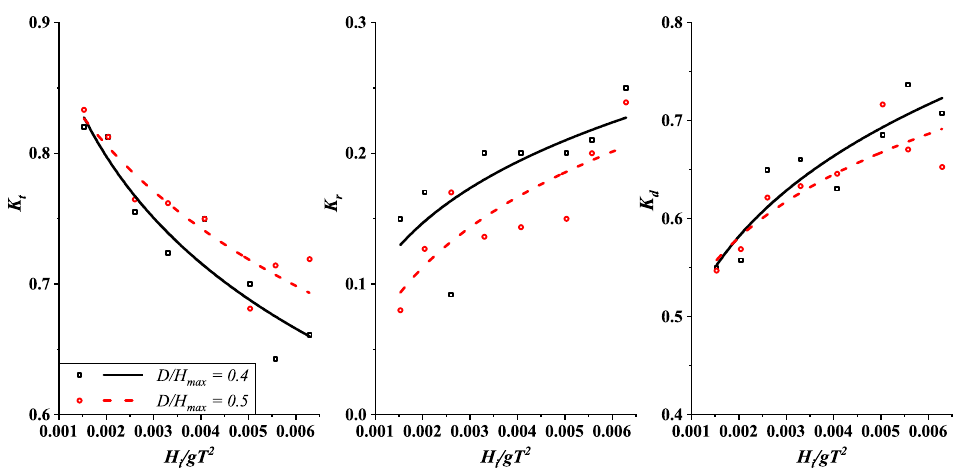
Figure 12. Performance comparison between different diameters of non-perforated